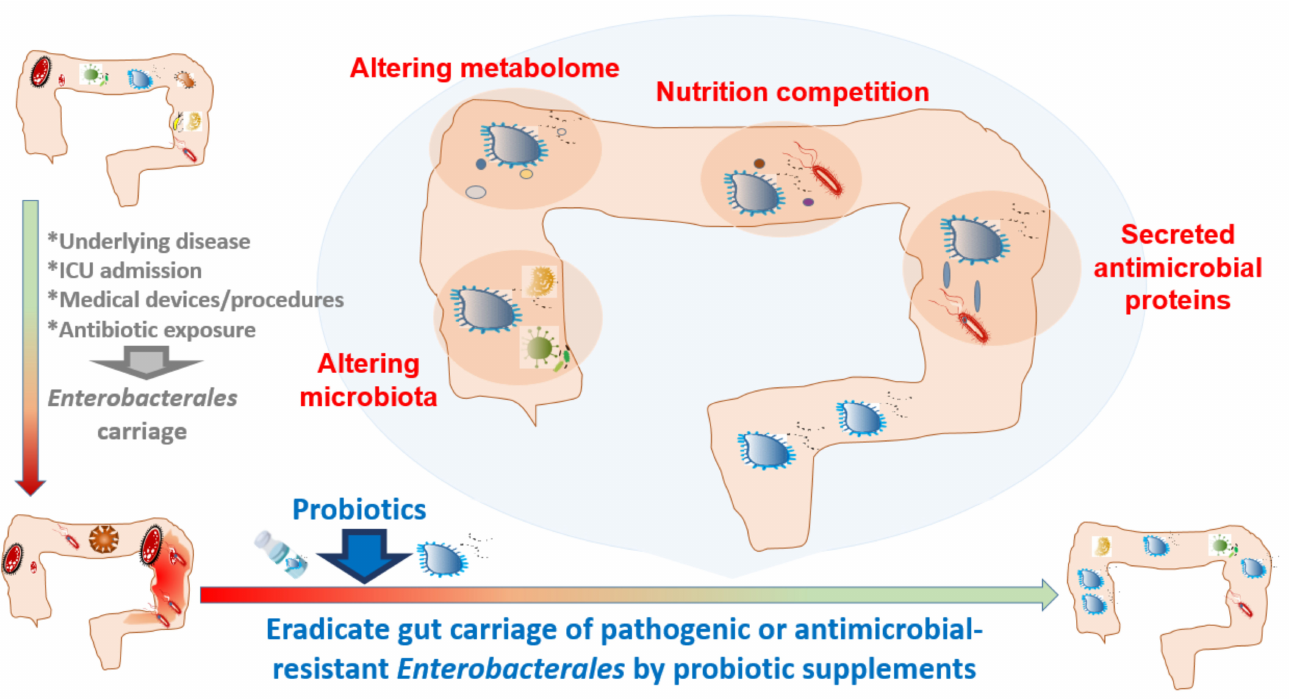
Figure 1. In humans, some clinical settings or interventions might promote intestinal carriage of Enterobacterales . Probiotics might be beneficial in eradicating gut carriage of pathogenic or antimicrobial-resistant Enterobacterales